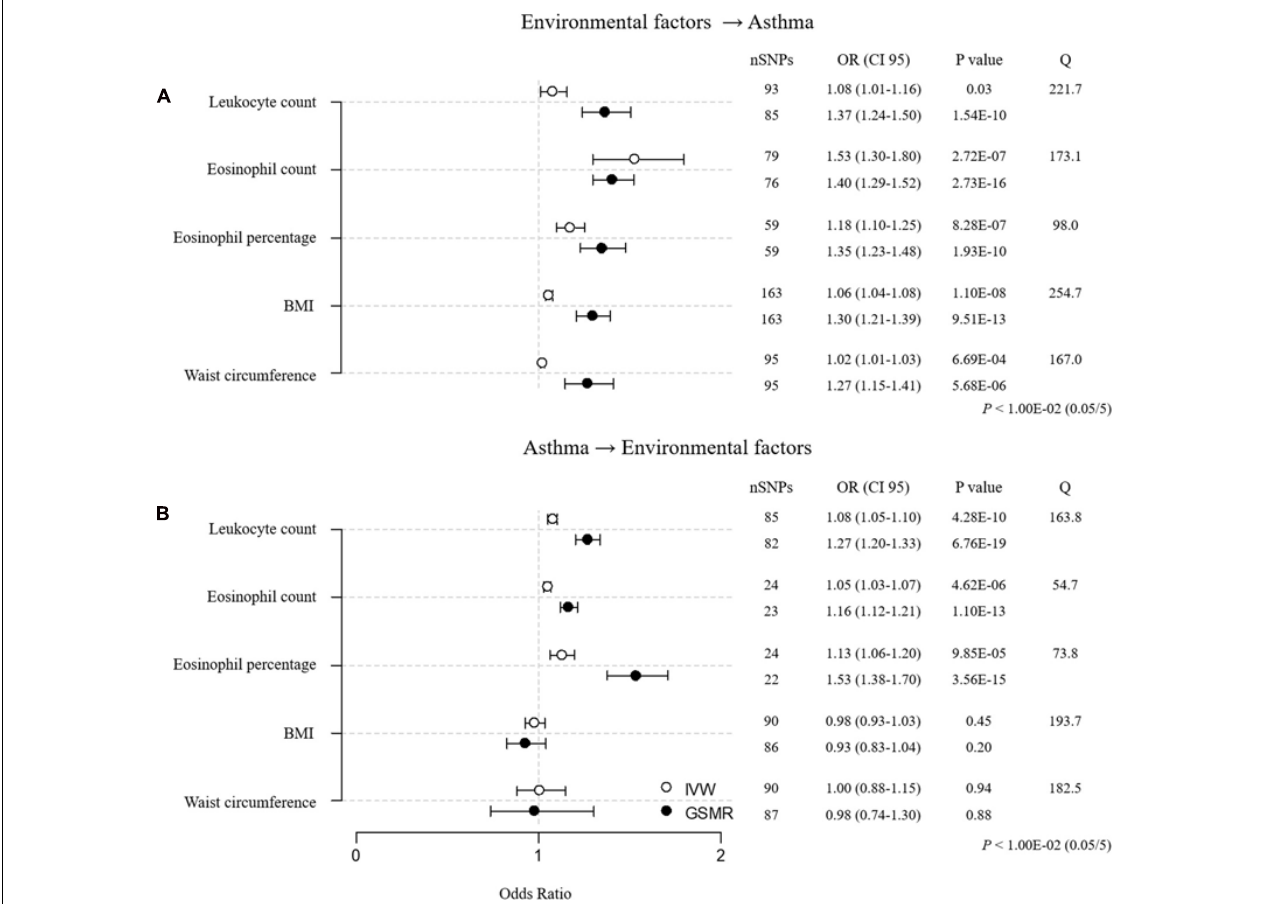
FIGURE 2 | MR estimates for associations between 5 environmental factors and asthma after sensitivity analysis. (A) Forward MR: environmental factors → asthma. (B) Reverse MR: asthma → environmental factors. The odds ratio is plotted as dots with the 95% confidence interval. White dots are the IVW method, and black dots are the GSMR method. The P value indicates significance when P < 1.00E-02 (0.05/5) by Bonferroni correction. The Q value by Cochran’s Q statistic indicates residual heterogeneity in the MR estimates.